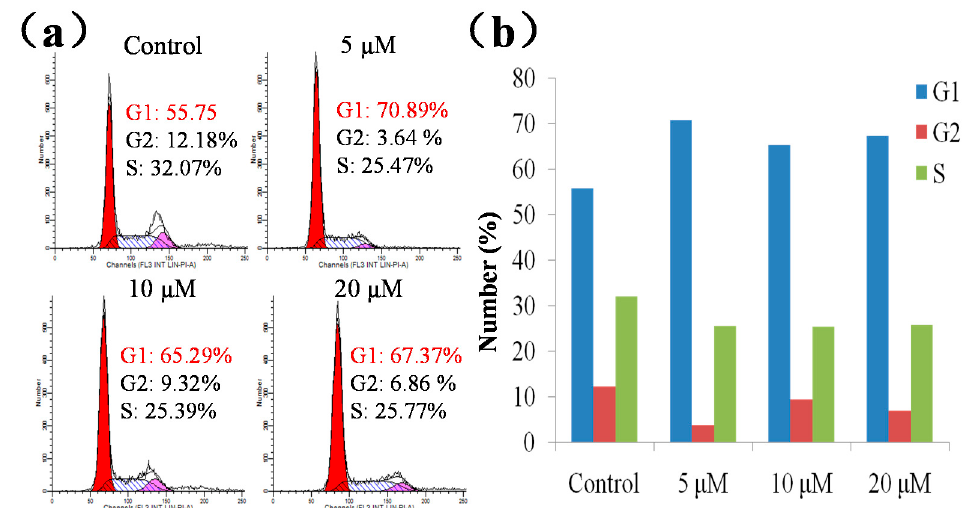
Figure 1. ( a ) G1-phase arrest of A549 cells induced by 1 ; ( b ) Change in cell cycle distribution of A549 cells induced by 1 . A549 cells were treated with 1 (0, 5, 10, and 20 μ M) for 24 h, almost 67.37% cycling cells were in the G1-phase and the sharp peak suggested that some cells were experiencing G1-phase delay or arrest.